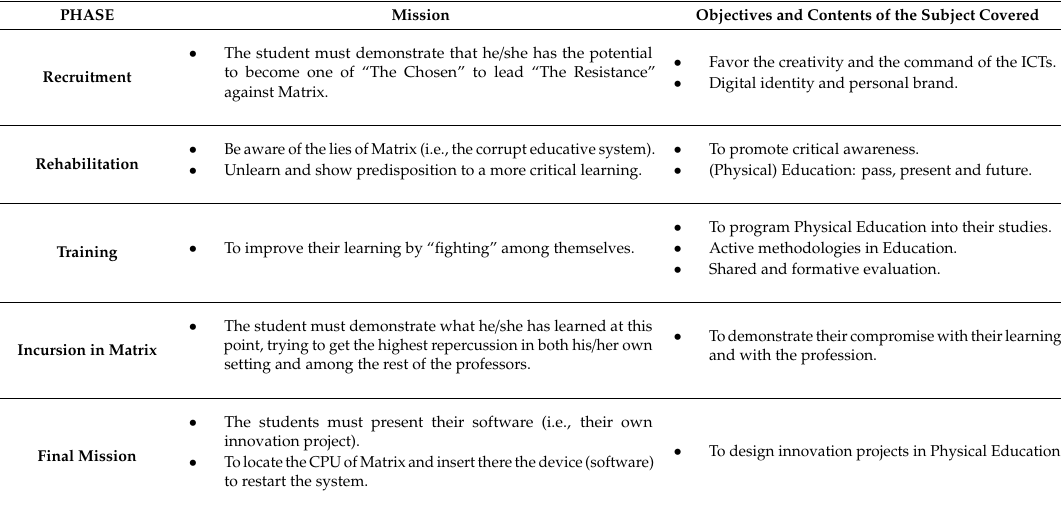
Table 1. Main missions, objectives and contents of the 5 phases of the “Matrix rEFvolution”.